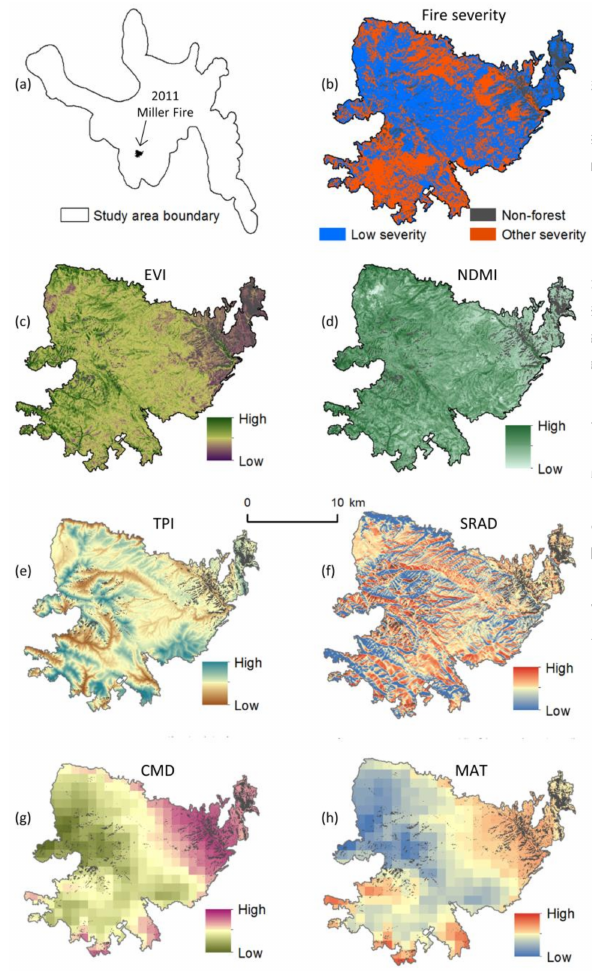
Figure 2. Example shows one of the >400 fires evaluated. Location of the 2011 Miller fire within the study area ( a ). Fire severity for the 2011 Miller Fire ( b ). Examples of the variables we used to represent pre-fire fuel ( c , d ), topography ( e , f ), and climate ( g , h ) for the 2011 Miller Fire. Inter-annual climate variation is not shown here because such variables are more indicative of temporal variability as opposed to spatial variability for individual fires. EVI: enhanced vegetation index; NDMI: normalized differenced moisture index; TPI: topographic position index; SRAD: solar radiation; CMD: climatic moisture deficit; MAT: mean annual